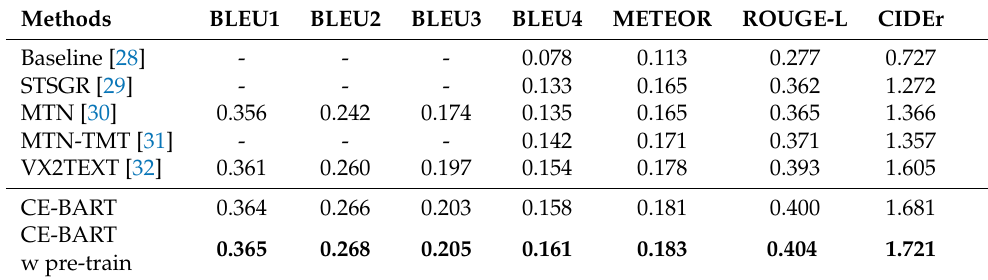
Table 4. Comparison with state-of-the-art methods on the AVSD benchmark. We compared CE-BART with various state-of-the-art systems on the AVSD benchmark: baseline [28], STSGR [29], MTN [30], MTN-TMT [31], and VX2TEXT [32]. The best results are in bold